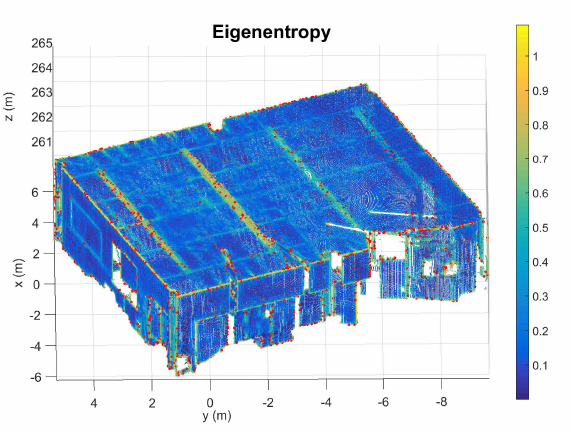
Figure 6. Classroom point cloud keypoints (red) from the entropy